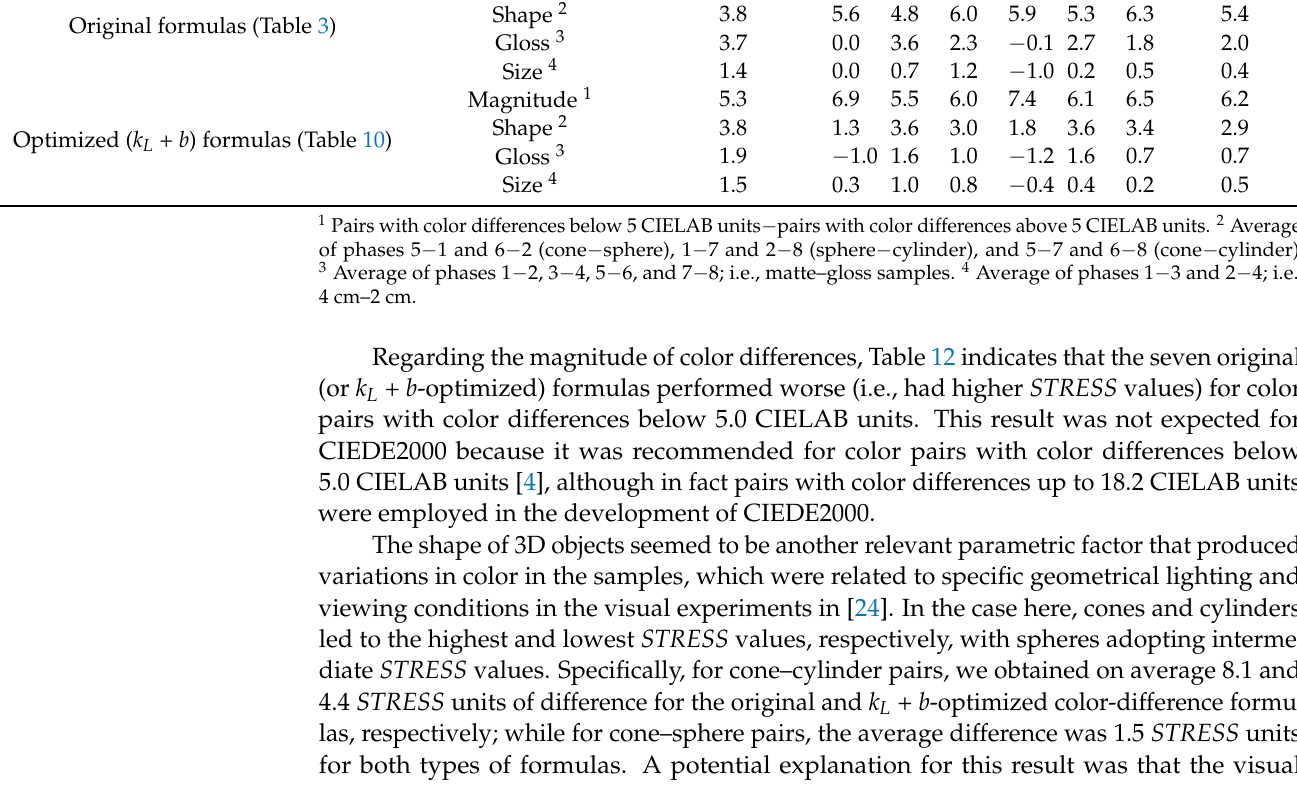
formulas (Table 10) while considering the following four parametric factors: color-difference magni-